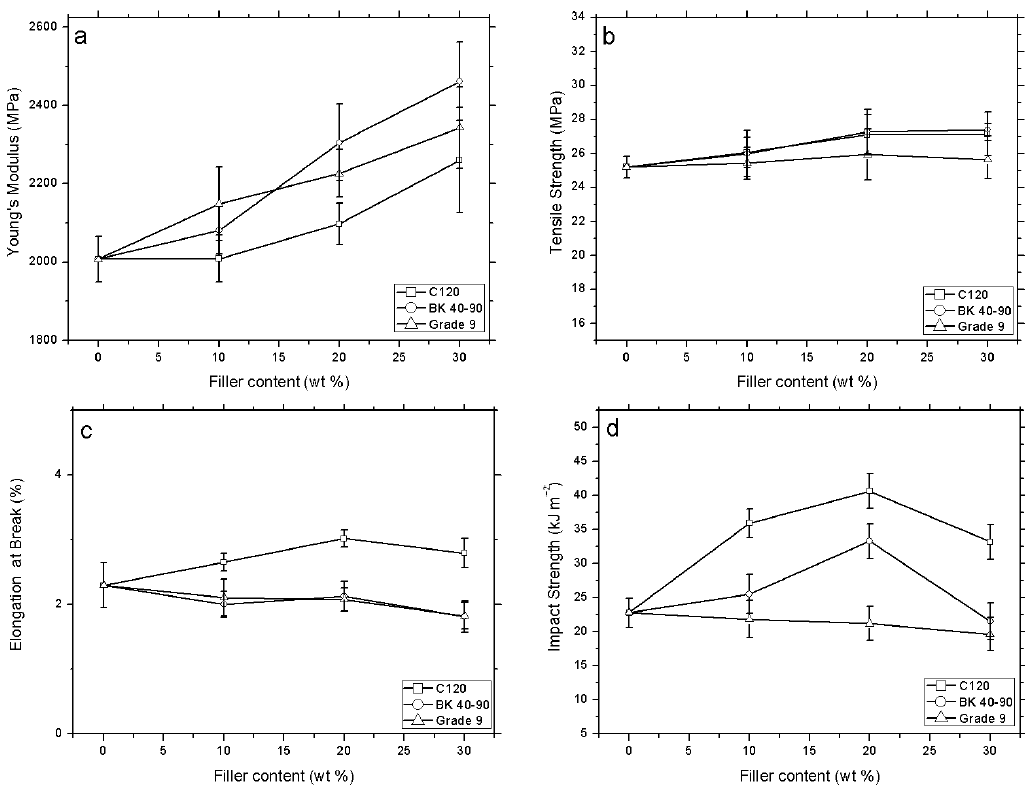
Figure 9. Mechanical properties of different samples: ( a ) Young’s modulus, ( b ) tensile strength, ( c ) elongation at break, ( d ) impact strength.